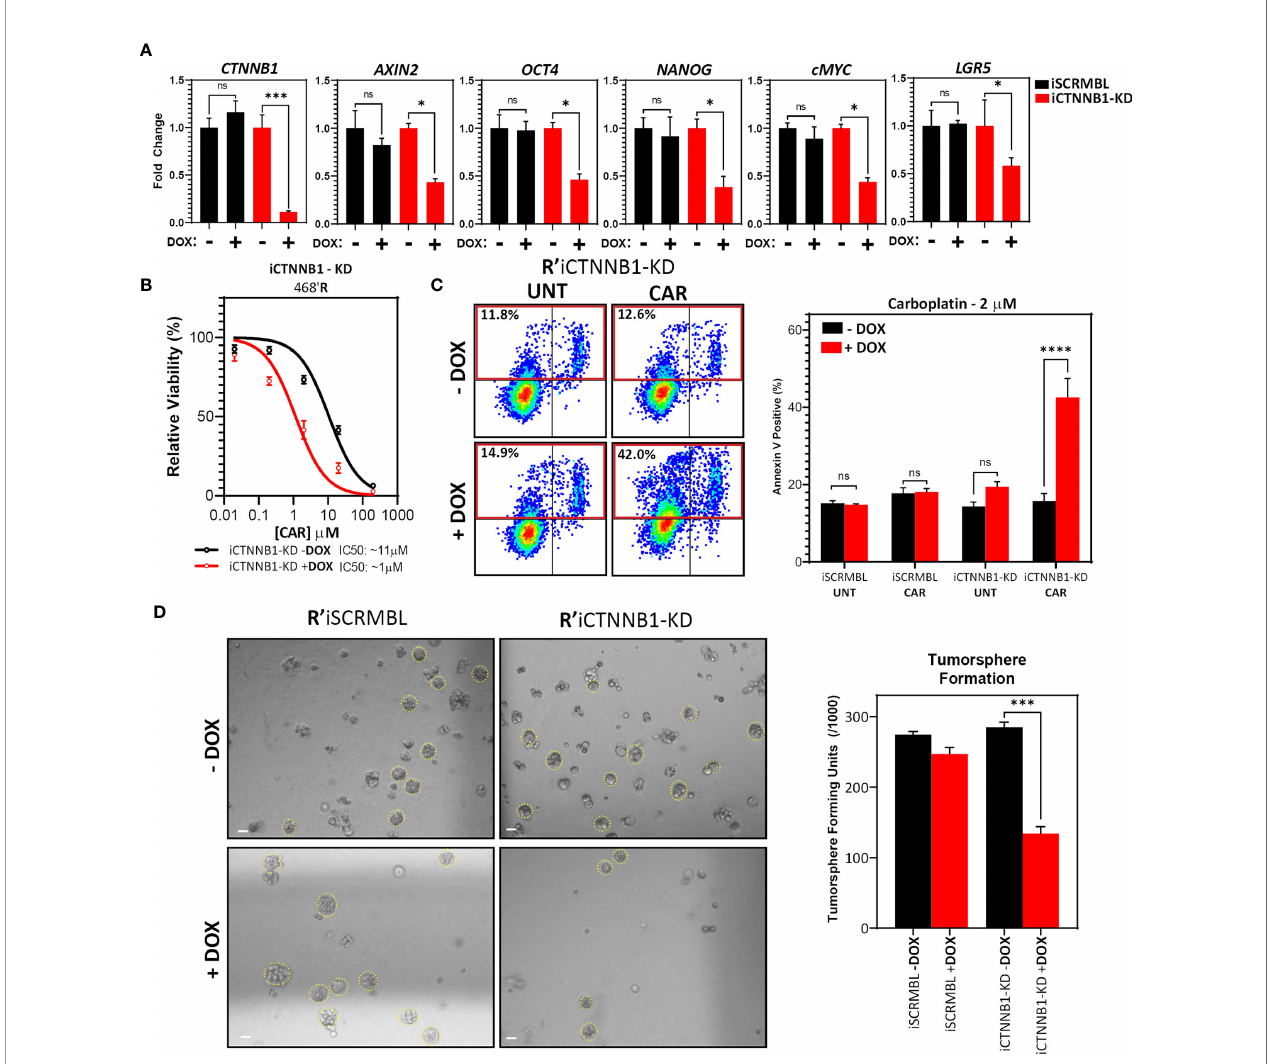
FIGURE 5 | Inducible b -catenin shRNA disrupts carboplatin-resistance and stem cell function in 468 ’ R cells . (A) Relative mRNA expression level of CTNNB1 ( b -catenin) and Wnt target and pluripotency markers in 468 ’ R cells transduced with inducible CTNNB1-targeting or SCRMBL shRNAs, in the presence or absence of doxycycline (n=3). Welch ’ s t-test (Dox vs . no Dox). (B) Non-linear fi t model of [CAR] vs normalized response for IC50 determination in iCTNNB1-KD cells in presence or absence of doxycyclin. (n=3, R 2 + DOX: 0.93, R 2 - DOX: 0.95). (C) Representative scatterplots of fl ow cytometric analysis of apoptosis by annexin V staining of 468 ’ R iCTNNB1-KD and 468 ’ R iSCRBML cells treated with or without 2 m M carboplatin for 72h in presence or absence of doxycycline (left) and corresponding statistical analysis of the mean frequency of annexin V positive cells (right, n=6). One-way Anova with correction for multiple comparisons using the Holm-Sidak method. (D) Representative bright fi eld images of tumorspheres generated from 468 ’ R iSCRMBL and 468 ’ R iCTNNB1-KD cells (left, scale bar: 50 m m) and statistical analysis of mean tumorsphere forming units (number of spheres/number of seeded single cells) (right; n=3). Welch ’ s t-test (Dox vs . no Dox). (Barplots represent mean + SEM. * p < 0.05; ***p < 0.001; ****p < 0.0001 ; ns, non signi fi